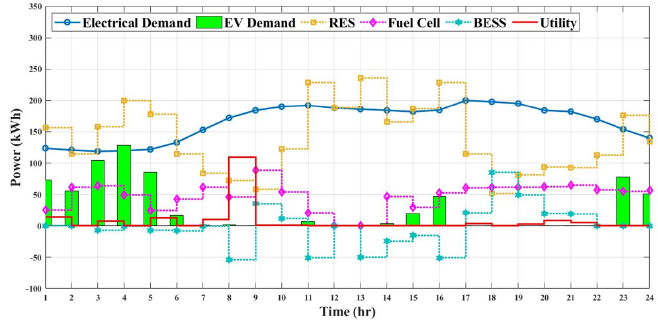
Figure 13. Optimized generation schedule with BSS